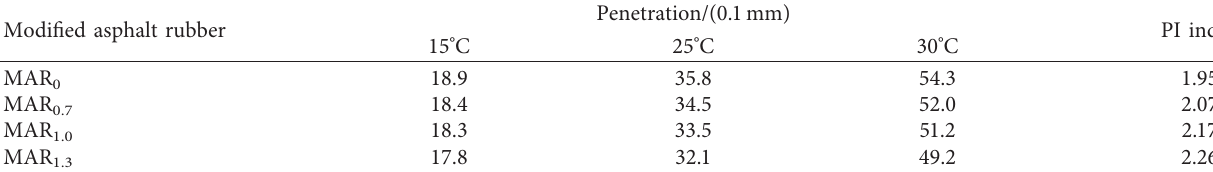
Table 5: Asphalt rubber PI index.